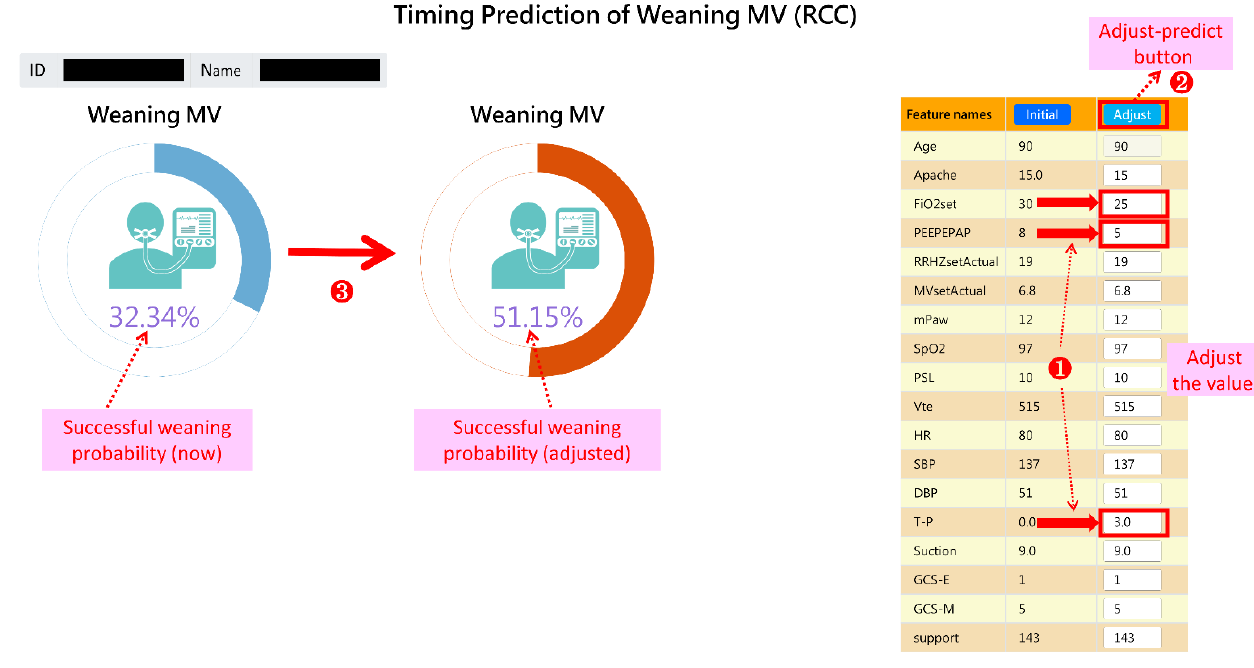
Figure 5. A screenshot of a specific patient’s inter active prediction.